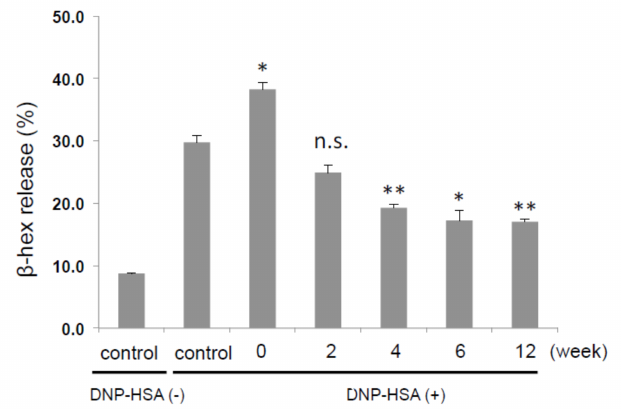
Figure 2. Inhibitory e ff ect of DMSO extract from fermented Jabara on β -hex release from mast cells. IgE-sensitized mast cells (1.0 × 10 5 cells / well) were preincubated with each extract (200 µ g / mL) at 37 ◦ C for 15 min prior to 30 min stimulation with DNP-HSA. Results represent one trial. At least three additional trials show similar results. Data are presented as mean + SD. * p < 0.05, ** p < 0.01, two-tailed Student’s t -test. n.s., not